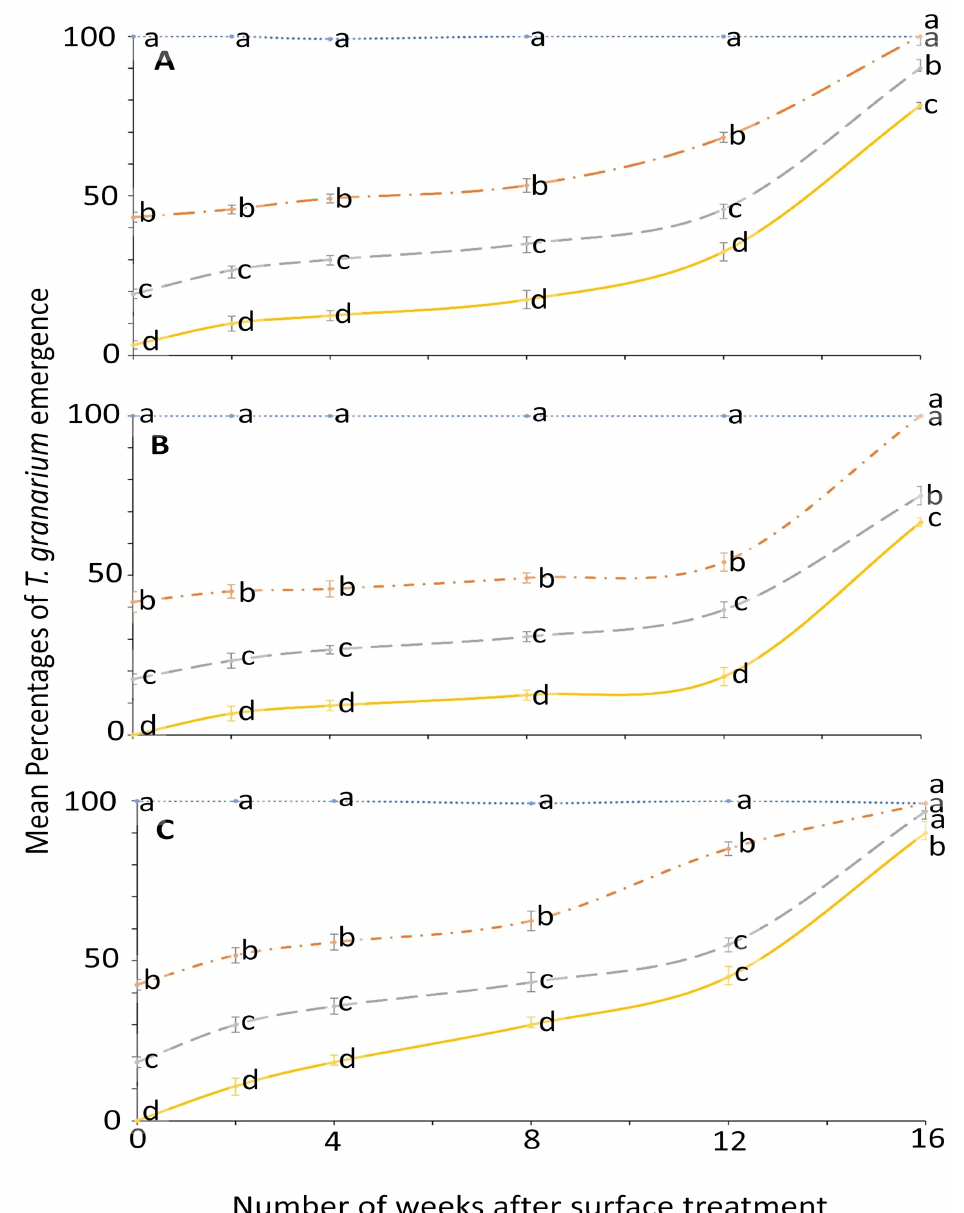
Figure 5. Mean percentages of adults emerging from last-instar T. granarium after exposure to novaluron applied 0–16 weeks previously at concentrations of 4- (solid line), 2- (dashed line), 1- (dashed-dotted line), or 0-ppm (dotted line) onto different surfaces: ( A ) concrete; ( B ) metal; or ( C ) wood. In comparisons among mean emergence percentages from different concentrations tested on a given week after application to a specified surface, designated a–d above, means with the same letter are not significantly